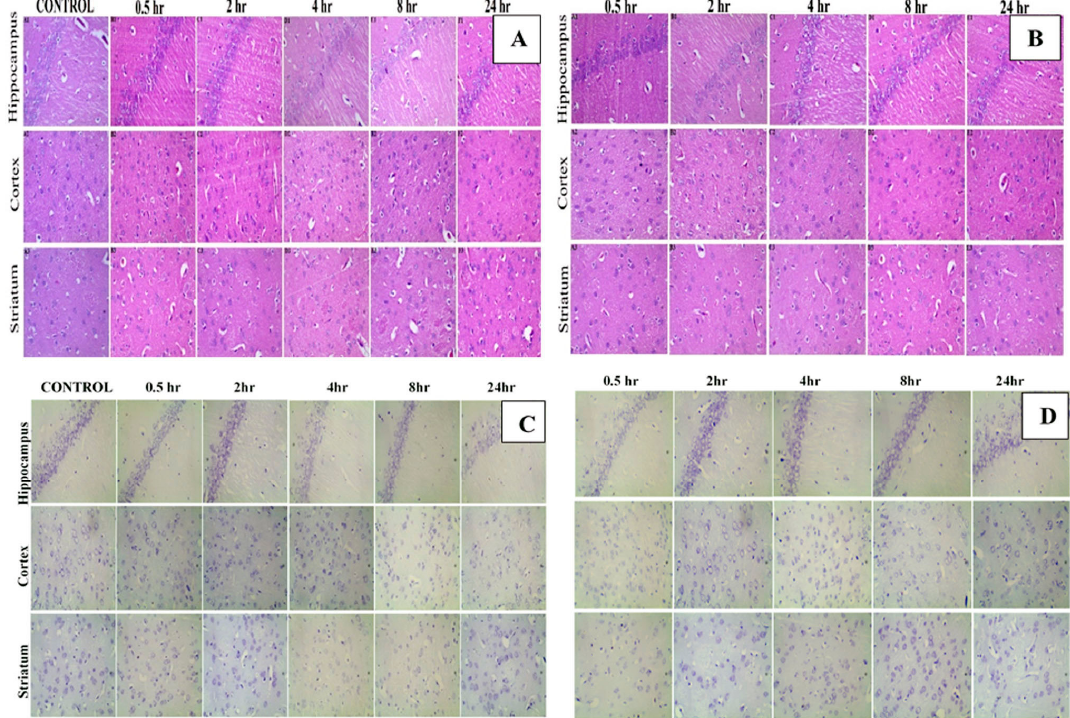
Figure 9. Hematoxylin and eosin staining of the brain for ( A ) ATZ-NLC and ( B ) ATZ suspension. Cresyl violet staining of brain for ( C ) ATZ-NLC and ( D ) ATZ suspension.